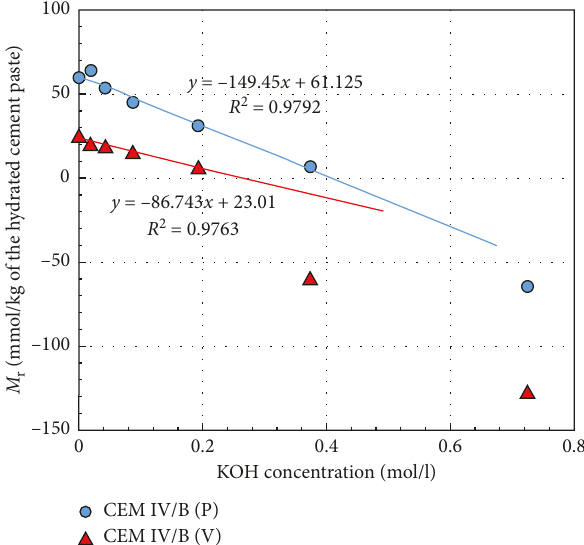
Figure 4: Relationship between M